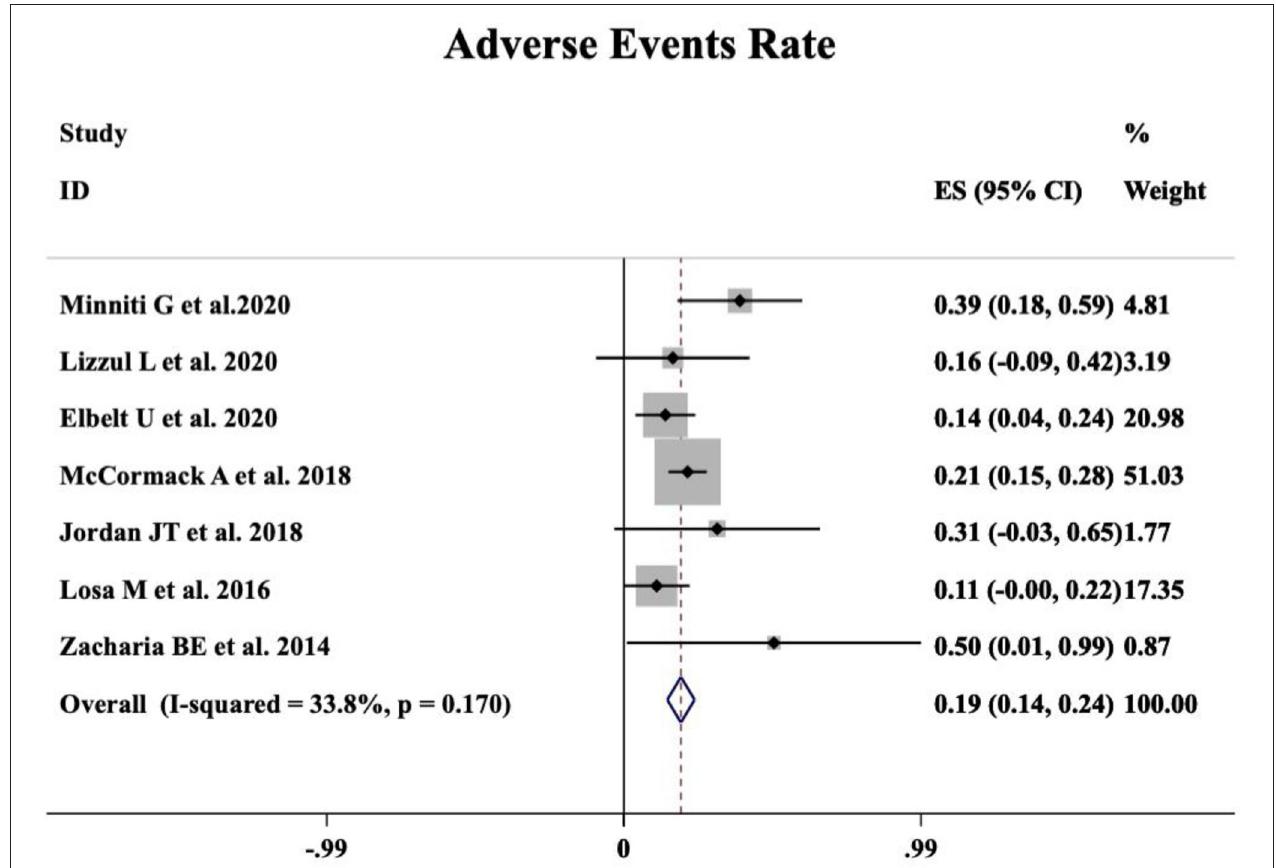
FIGURE 3 | Occurrence of TMZ-related adverse